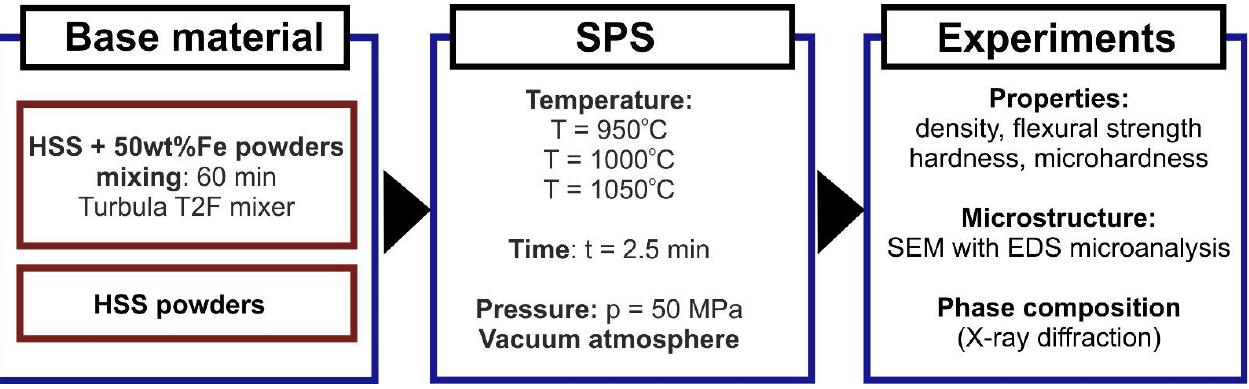
Figure 3. Scheme of T15, T15+50%Fe materials manufacturing process and experimental investiga- tions.